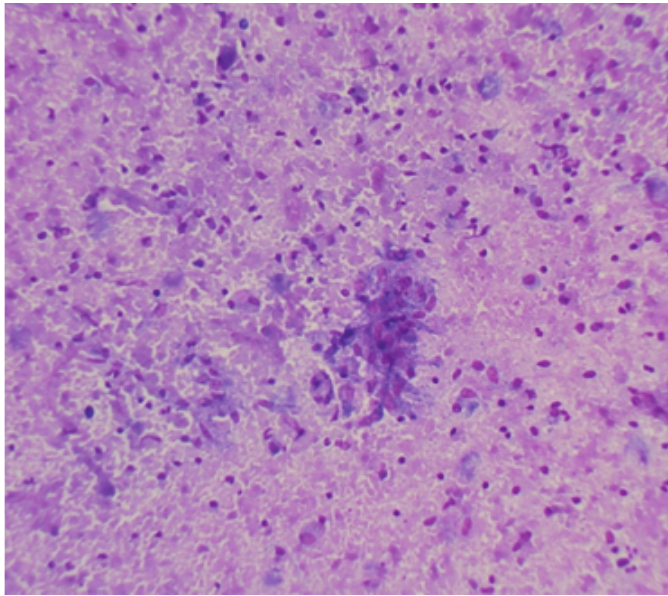
Figure 1 : Photomicrograph showing Epithelioid cell granuloma with a necrotic background (Pattern B); 100x (MGG).